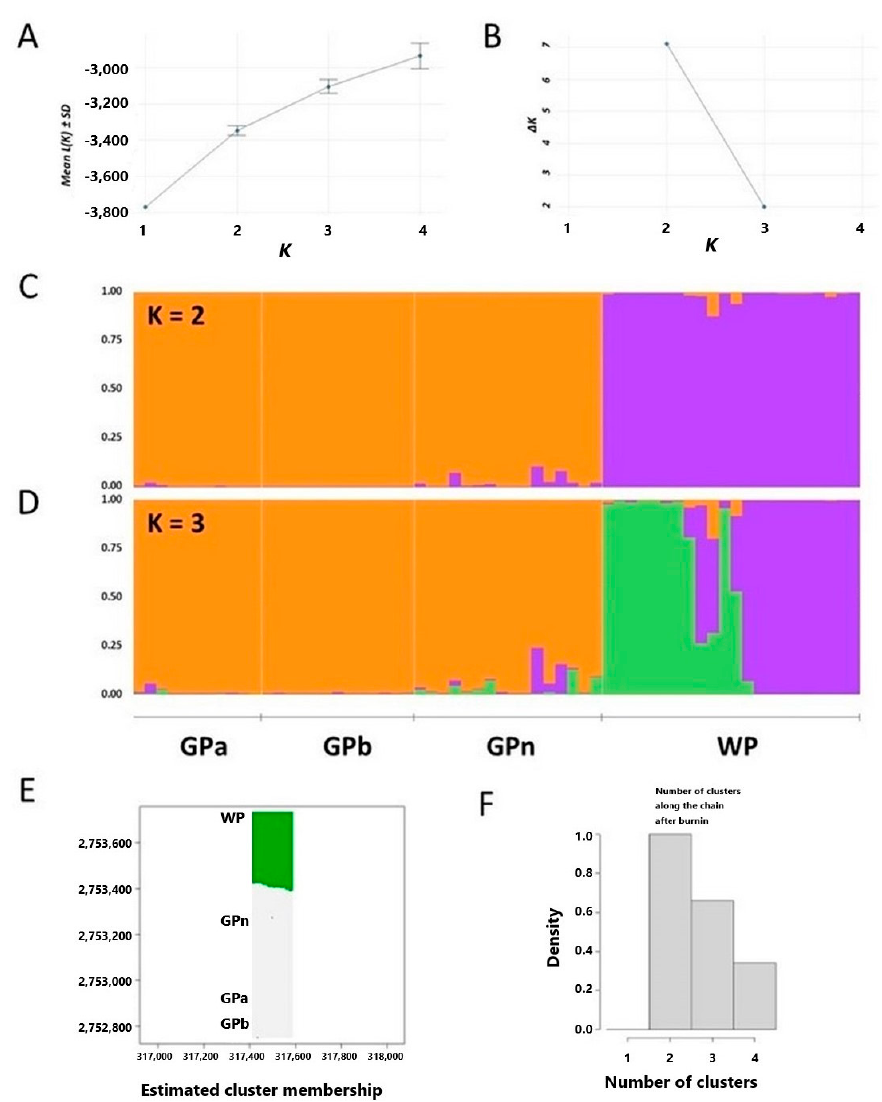
Figure 5. The estimated number of clusters (K) of the four N. shimadai populations in northern Taiwan based on the results of the Evanno method in STRUCTURE output. ( A ) Mean L/K (estimated probability value for each K value), ( B ) inferred cluster based on delta K ( Δ K), genetic clusters based on K = 2 ( C ) and K = 3 ( D ), and ( E ) Geneland analysis for georeferenced genotypes where ( F ) K = 2 has the highest probability based on the convergence of MCMC iterations.